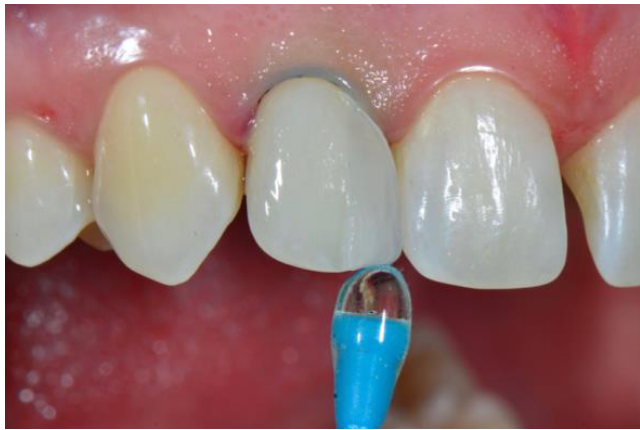
Figure 8. Prefabricated veneer seated in position until connection with the adjacent tooth.